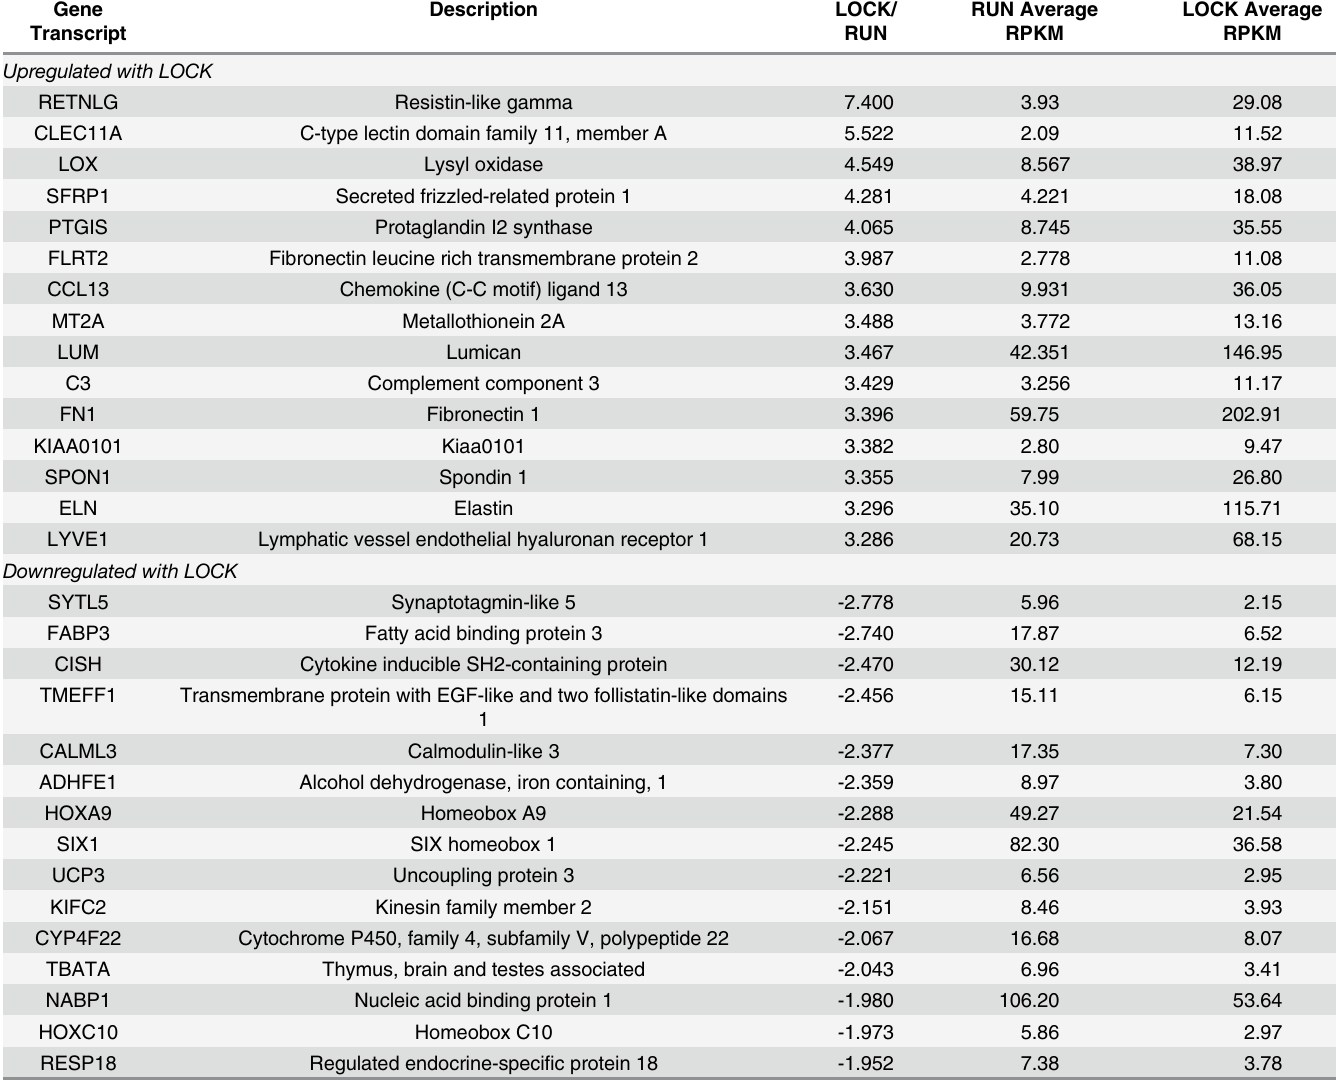
Table 3. Top 15 up and down regulated genes differentially expressed between continued wheel access (RUN) and wheel locking (LOCK), sorted by magnitude of fold change. Gene